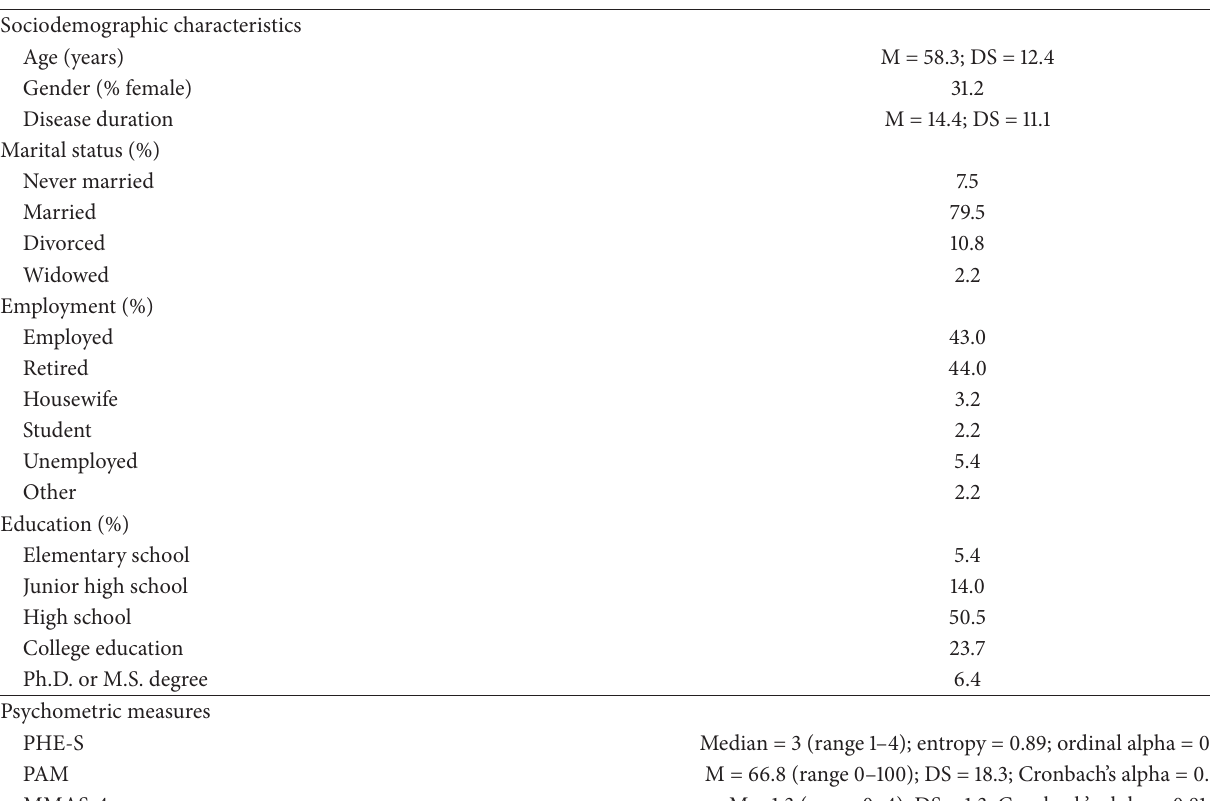
Table 1: Characteristics of the sample.